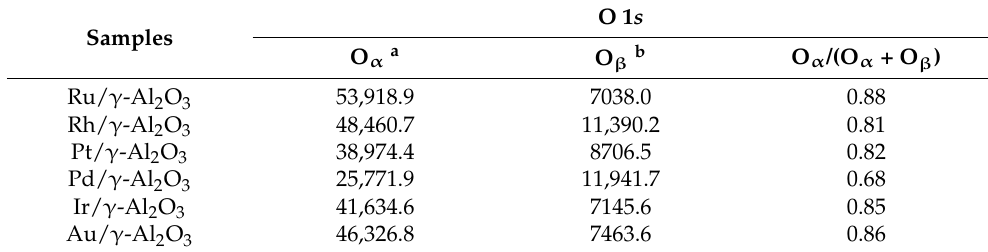
Table 3. XPS results of O 1s of prepared